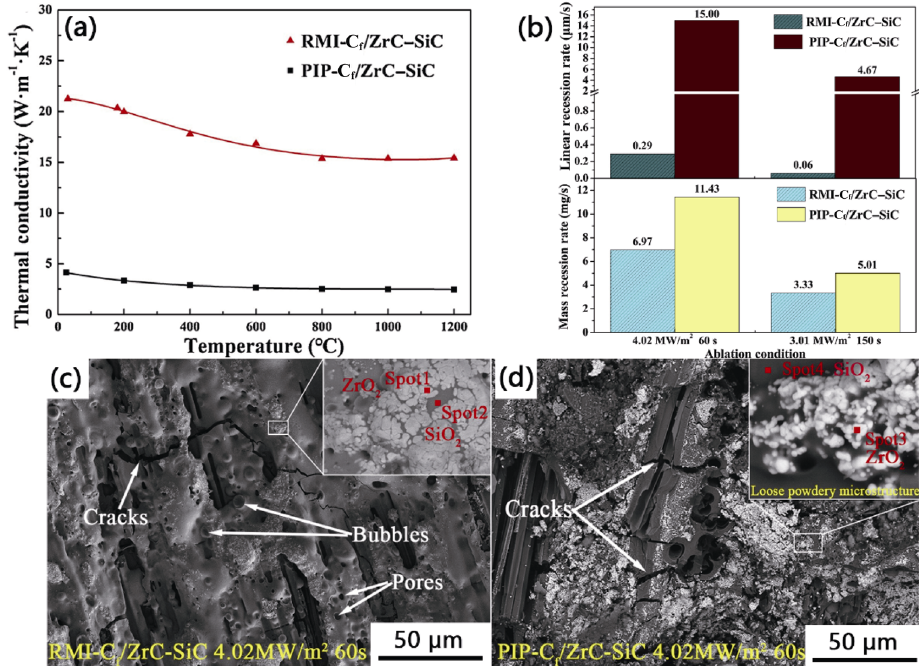
Fig. 29 Thermal conductivity of RMI-C f /ZrC–SiC and PIP-C f /ZrC–SiC composites (a), ablation recession rates (b), and the ablated surface microstructure of RMI-C f /ZrC–SiC (c), and PIP-C f /ZrC–SiC composites (d). Reproduced with permission from Ref. [239], © Elsevier Ltd.